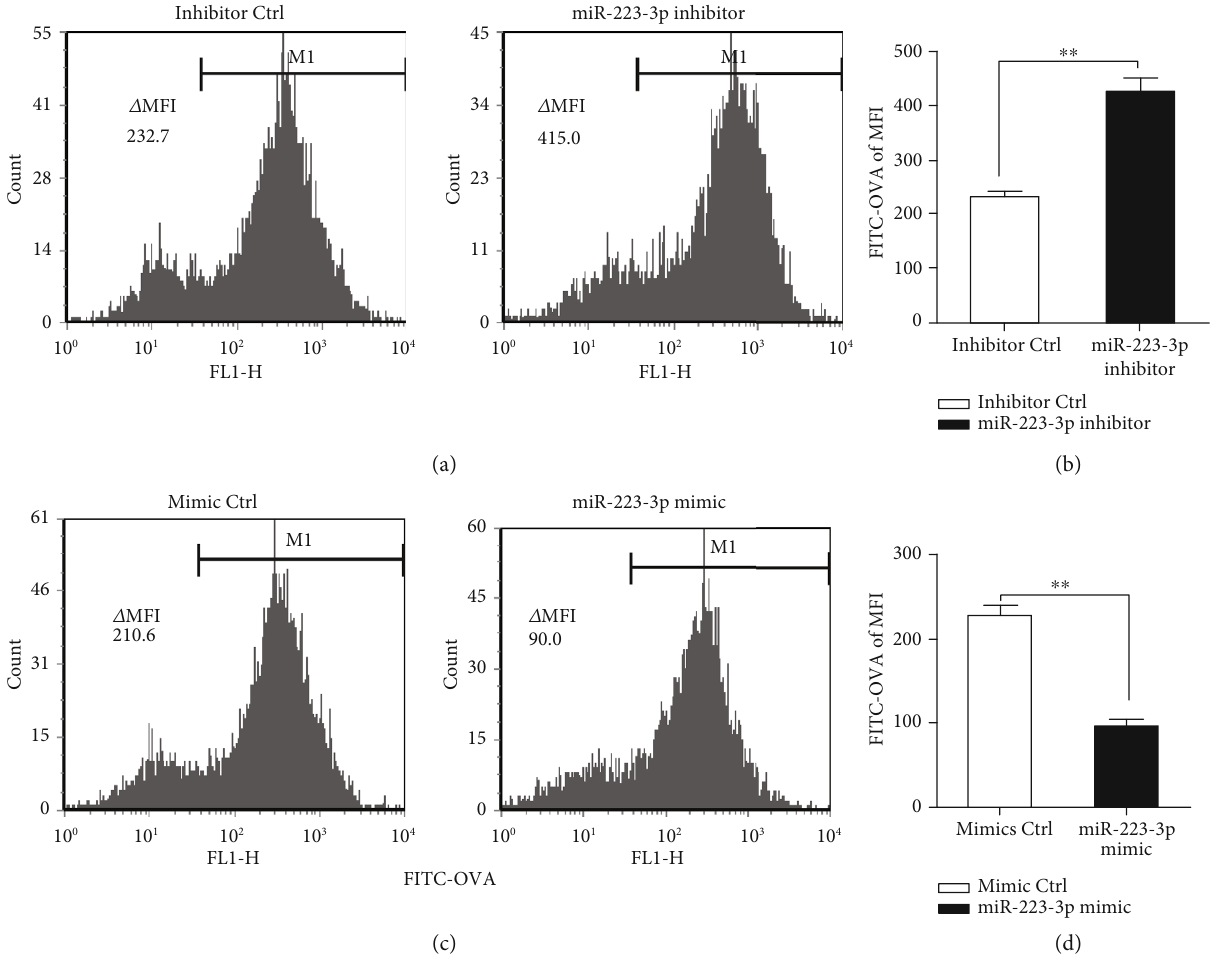
Figure 2: miR-223-3p suppressed OVA endocytosis of BMDCs. Mouse immature DCs were transfected with the miR-223-3p inhibitor (a, b), miR-223-3p mimic (c, d), and the corresponding controls at a fi nal concentration of 50nM. After 24 h of transfection, DCs were incubated with FITC-OVA for 30min and the endocytic activity (FITC-OVA uptake) of BMDCs was measured by fl ow cytometry. (b, d) The bar chart indicated the MFI in the gate of CD11c+ cells in each group. Similar results were obtained in three independent experiments. Data were shown as mean ± SD . t -test, ∗ P < 0 : 05 , ∗∗ P < 0 : 01